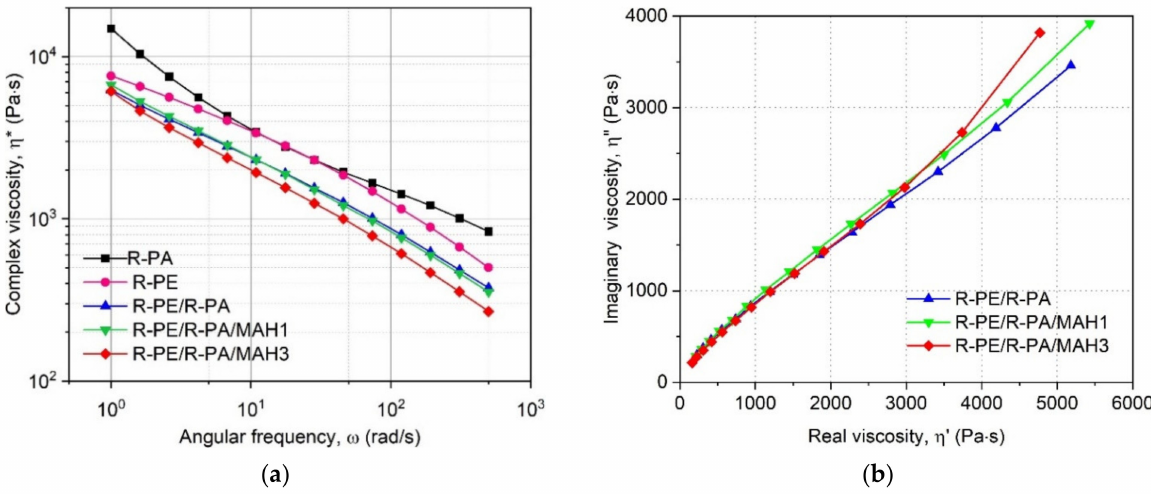
Figure 2. ( a ) Complex viscosity ( η *) as a function of angular frequency ( ω ) and ( b ) imaginary part of viscosity ( η ”) as a function of real part of viscosity ( η ’) of studied materials at 230 ◦